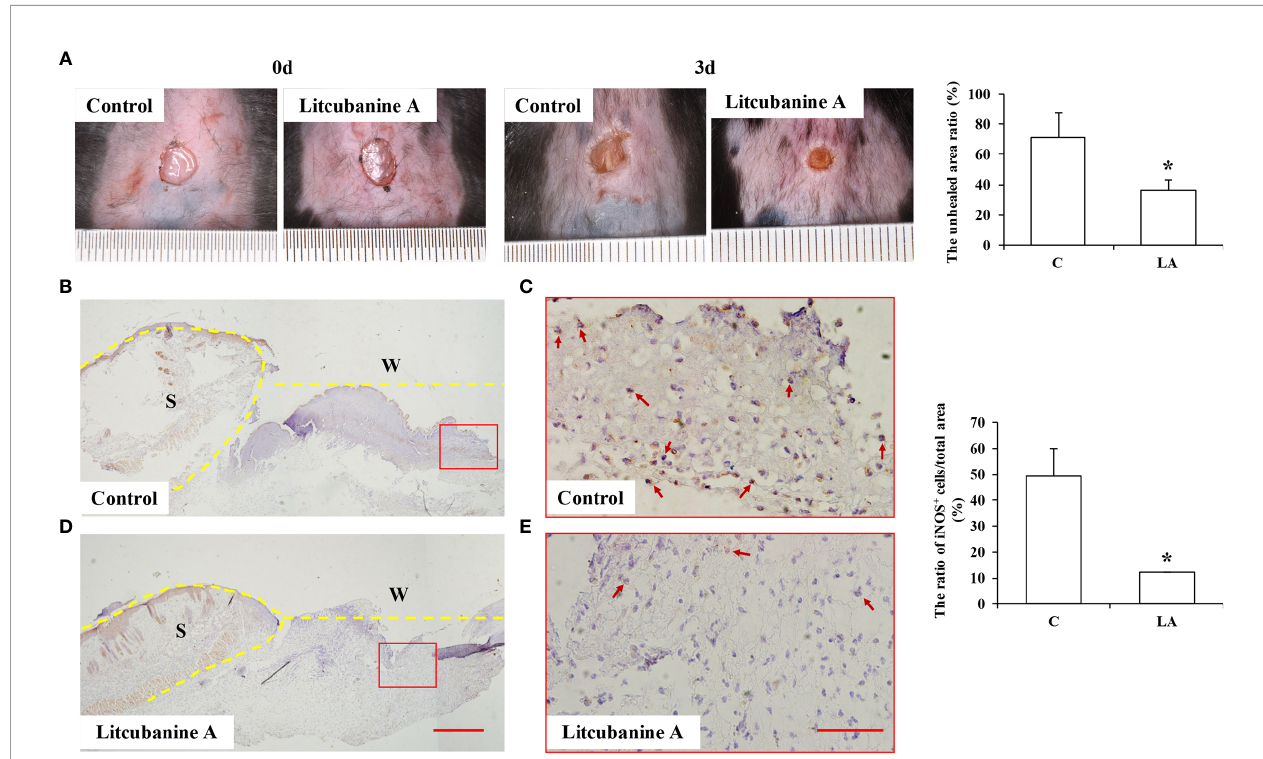
FIGURE 10 | LA injection promoted wound healing by inhibiting the local in fl ammatory macrophages activation (A) LA injection signi fi cantly promoted wound healing compared to the control group (n=5). (B – E) The local iNOS + in fl ammatory macrophages were observed using immunohistochemistry staining, and the results showed that by the third day after the surgery, the wound tissues in the control group showed an overexpression of iNOS (49.18% ± 10.84%). However, the iNOS + cells ratio was lower in LA group (12.22% ± 0.14%) compared to the control group (n=5). Scale bar = 500 m m in (D) and scale bar = 50 m m in (E) . S, Skin; W, Wound. Results were expressed as mean ± standard deviation (SD), and statistical signi fi cance was shown as *P <